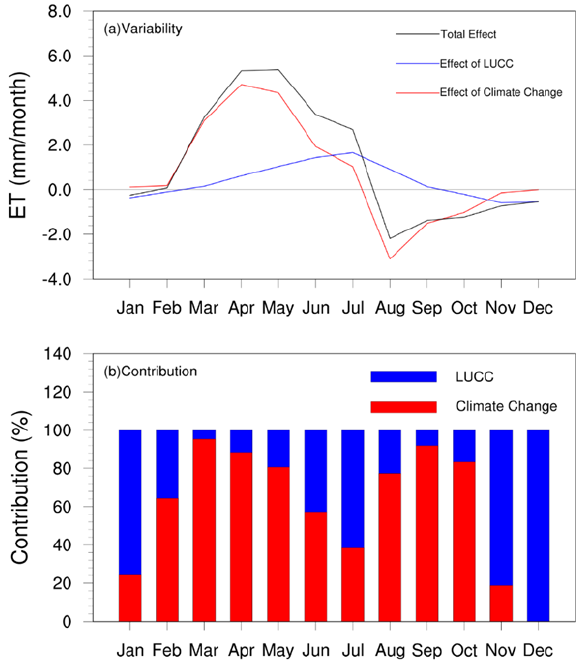
Figure 10. The fluctuations in the effects of climate change and land use/land cover (LUCC) on ET.